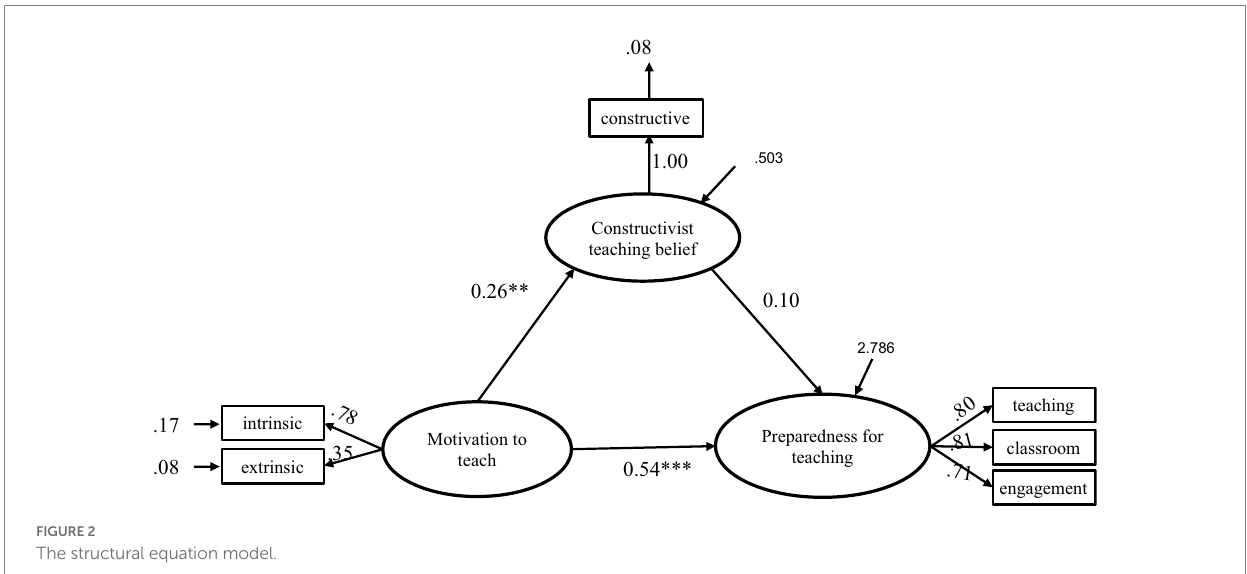
FIGURE 2 The structural equation